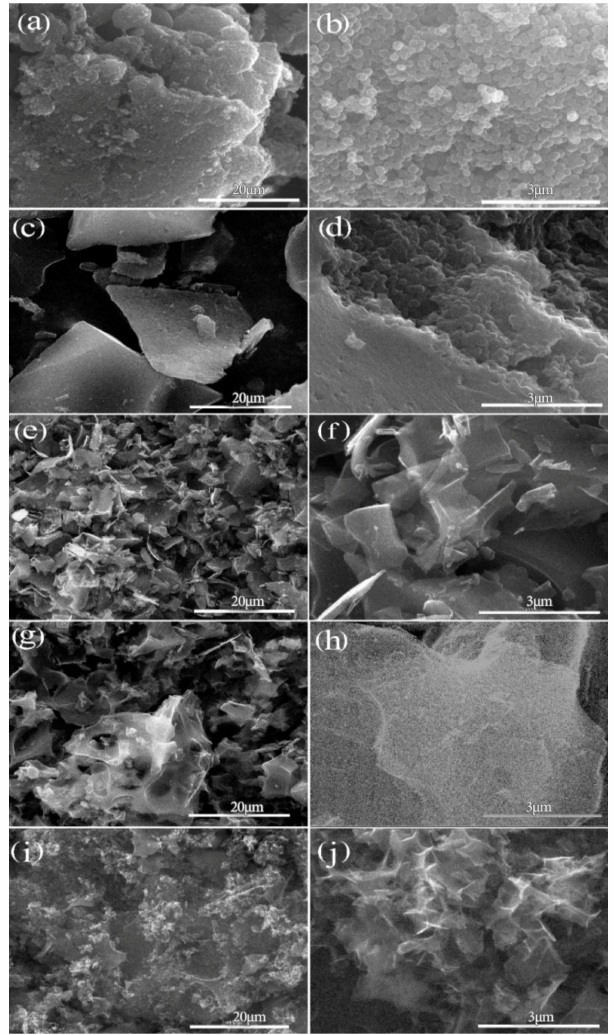
Figure 6. SEM morphology of different mass ratios of KOH and OPAN in one-step activation method: ( a , b ) APCNs0.05; ( c , d ) APCNs0.1; ( e , f ) APCNs0.5; ( g , h ) APCNs1; ( i , j )